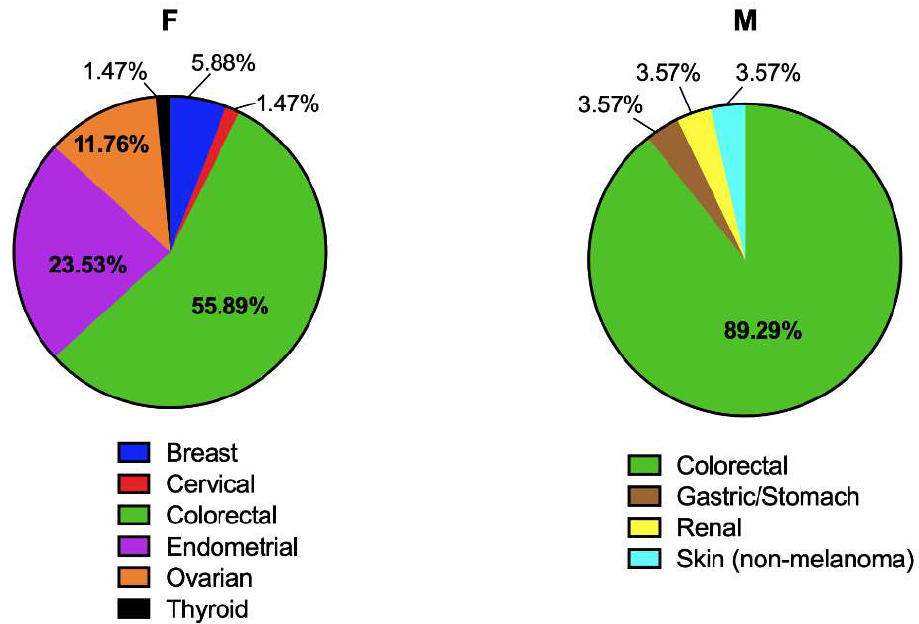
Figure 4. Site of incidence of pathogenic MMR variants identified by gender. Table 5. Type of cancer and histological subtype in patients with pathogenic MMR variants and number of patients with variants by MMR gene.